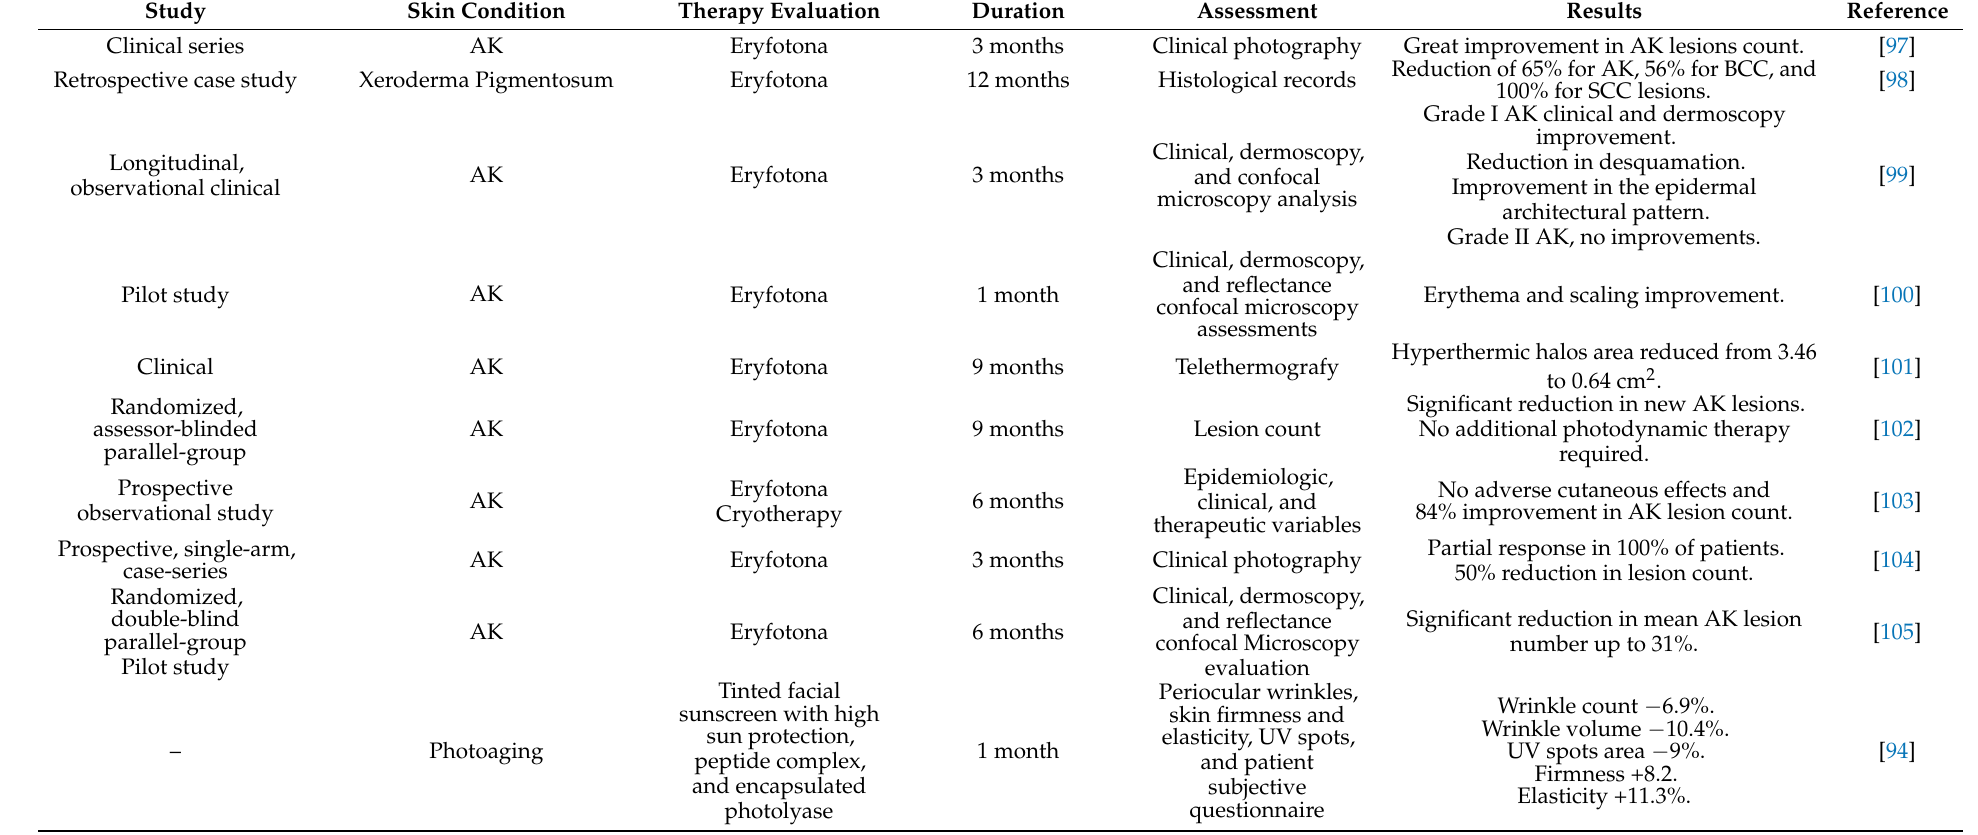
Table 2. Studies on the use of photolyase in different skin